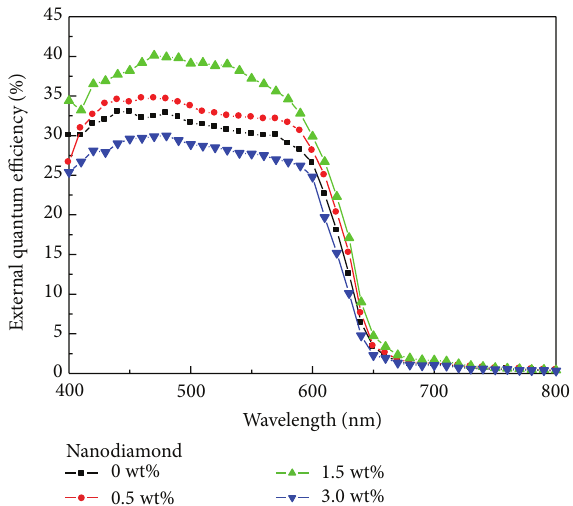
Figure 6: External quantum efficiency spectra of hybrid OPVDs doped with nanodiamond at various